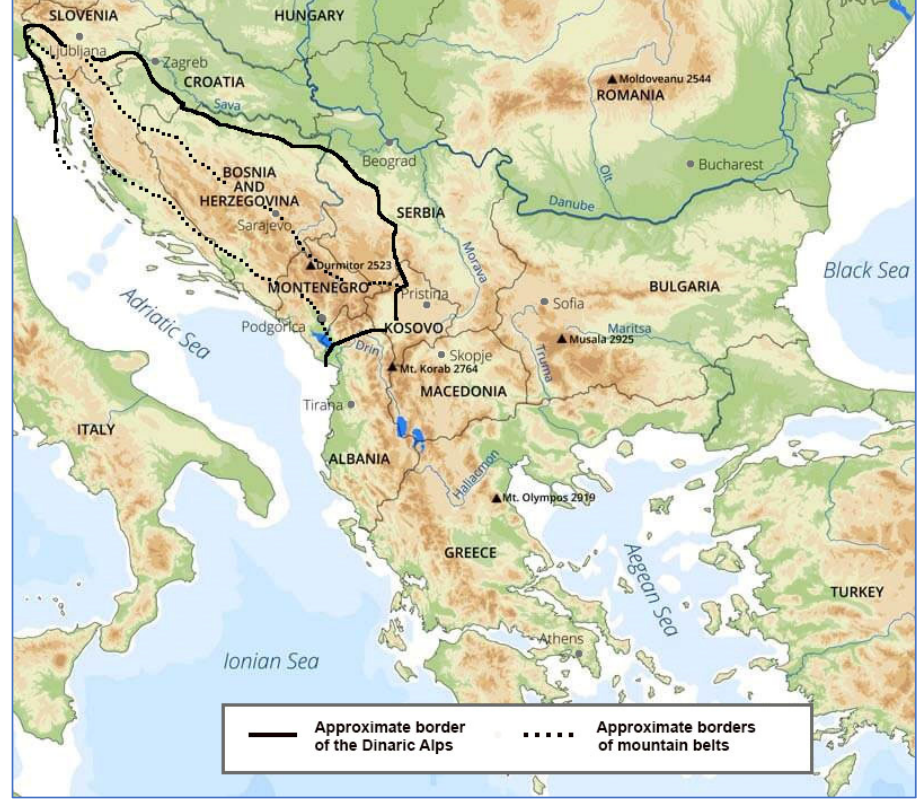
Figure 1. Approximate border of the Dinaric Alps.